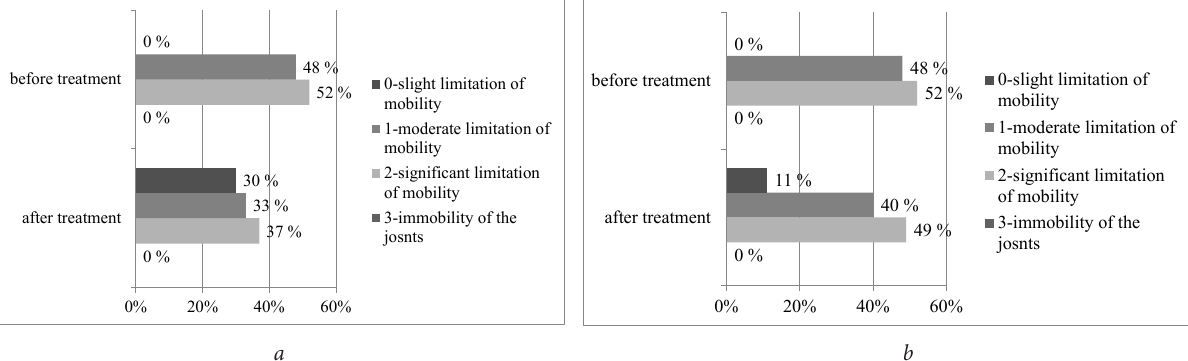
Fig. 1 . Assessment of joint mobility with the help of a goniometer before and after treatment in the groups under study: a – І group; b – ІI